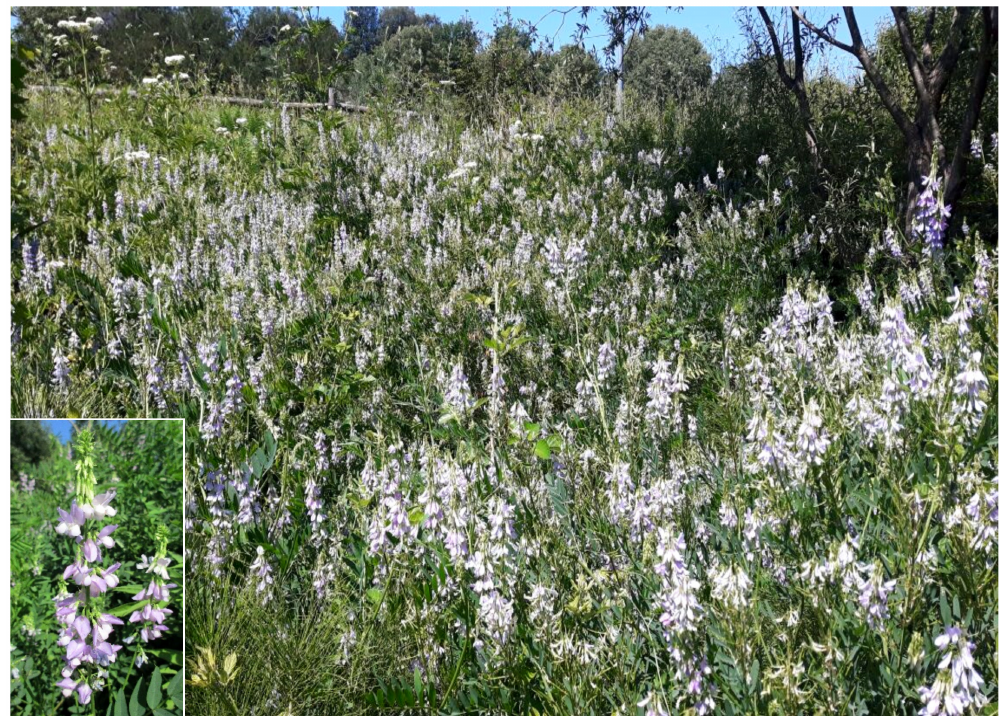
Figure 34. Galega officinalis L. dominated community, Epilobietea angustifolii (Acquedotti